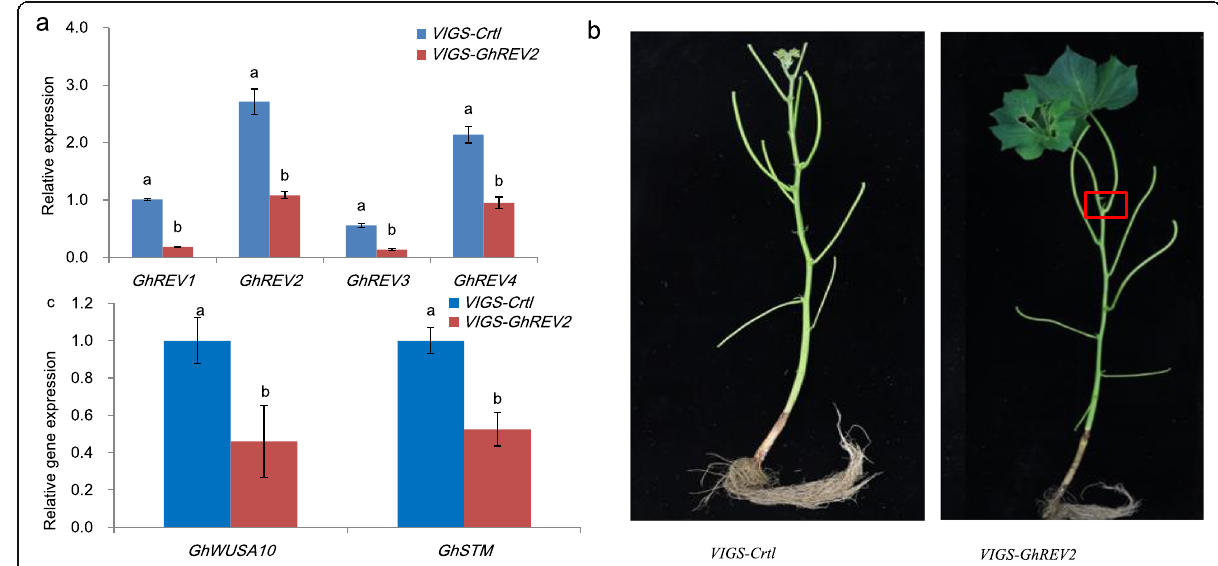
Fig. 5 Silencing of GhREV2 caused developmental defect of SAM. pTRV: GhREV2 Virus-induced gene silenced construct was injected into the fully expanded cotyledons. a The expression of GhREVs in shoot apex. The expression of GhREV1 in VIGS-Ctrl plants was regarded as ‘ 1 ’ . b The seedlings of VIGS-Ctrl (left) and VIGS- GhREV2 (right) after two months of VIGS treatments. The red box indicates the abnormal SAM of VIGS- GhREV2 seedling. c The expression of GhWUSA10 (left) and GhSTM (right) in shoot apex of VIGS- GhREV2 seedlings. The expression of GhWUSA10 in VIGS-Ctrl plants was regarded as ‘ 1 ’ . GhActin9 was used as the internal